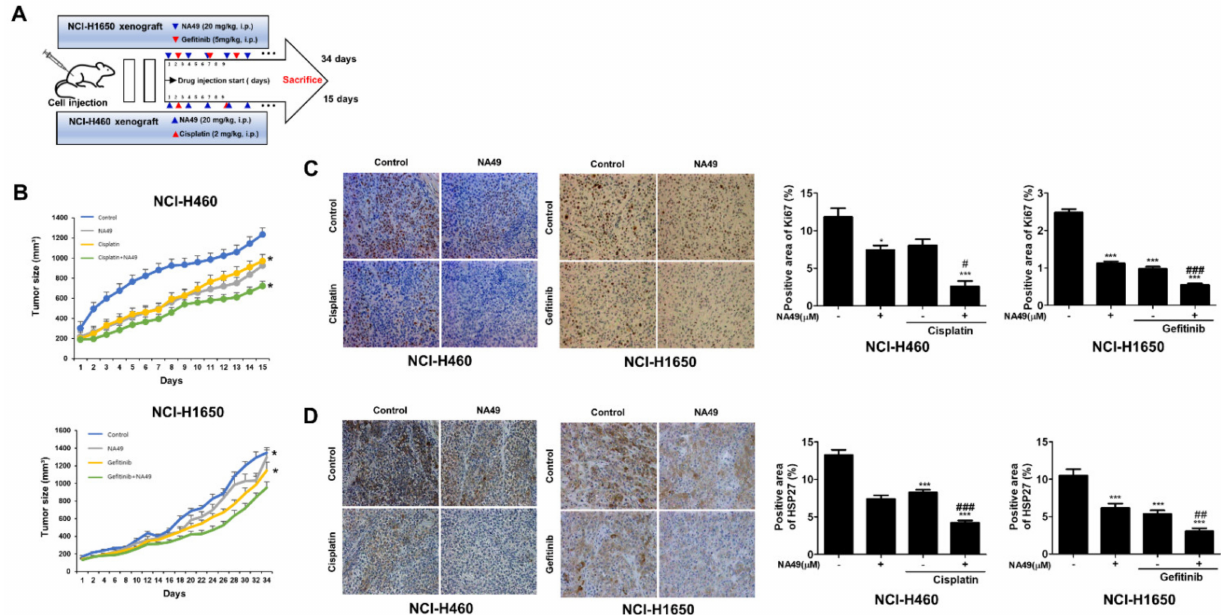
Figure 7. NA49 sensitized tumors in an NCI-H460 and NCI-H1650 cells-injected xenograft mouse model with cisplatin and ge-fitinib. ( A ) NCI-H460 and NCI-H1650 cells were injected subcutaneously into BALB/c nude mice ( n = 6/group). Xenografted mice were treated 7 times with NA49 (20 mg/kg) intraperitoneal treatment in combination with four injections of cisplatin (2 mg/kg) or gefitinib (5 mg/kg). ( B ) Tumor size was measured every other day. Results are the mean and standard error. ( C ) Ki67 staining ( D ) and immunohistochemistry of HSP27 were performed using tumor tissues. Results are the mean and standard error (* p < 0.05, *** p < 0.001 vs. untreated-control; # p < 0.05, ## p < 0.01, ### p < 0.001 ### vs. cisplatin or gefitinib